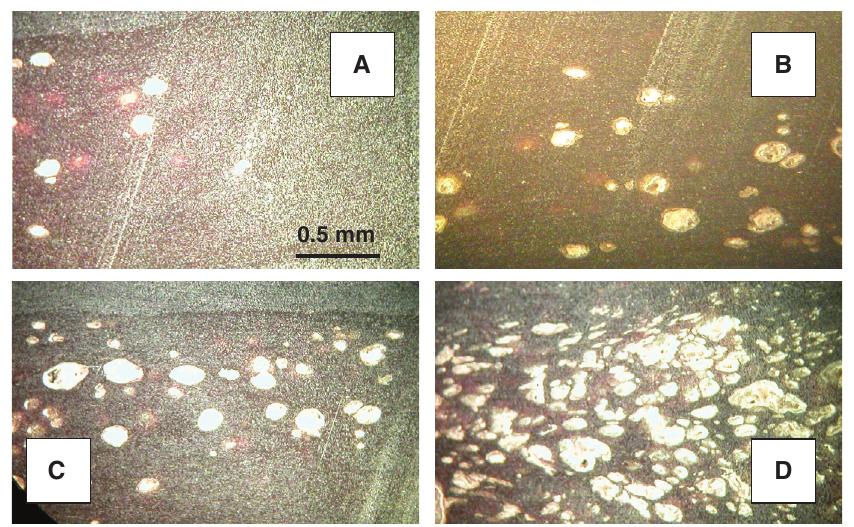
Figure 3 Typical void distribution in the four WPC panels: (A) WPC20, (B) WPC30, (C) WPC40, (D)